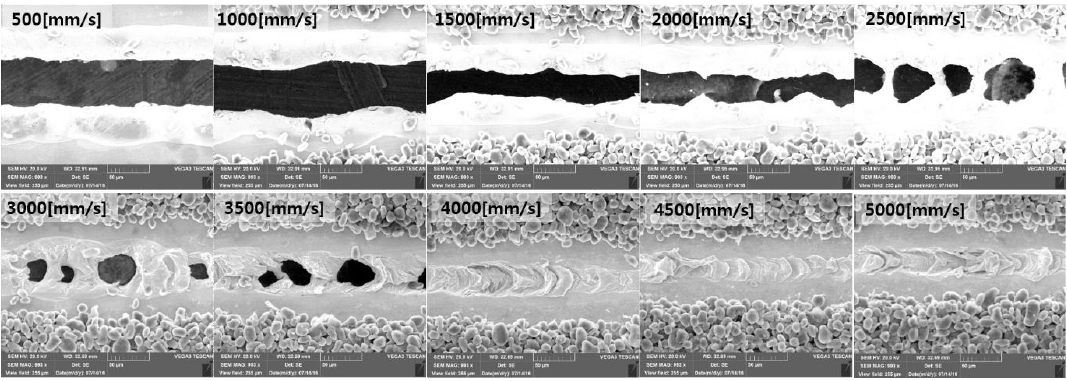
Figure 7. SEM images with a laser power of 250 W.